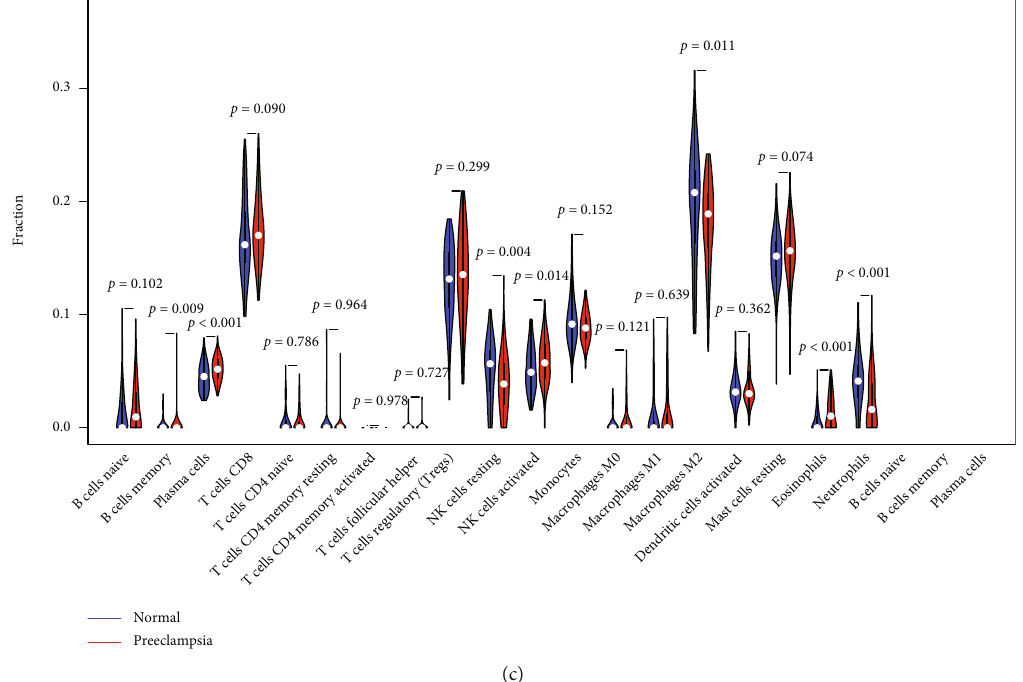
Figure 8: Immune cell pro fi le in preeclampsia samples and correlation analysis. (a) The amounts of immunocytes in every preeclampsia specimen are indicated with diverse colors. (b) Correlative matrix for the entire 22 immunocyte amounts. (c) Contrast of 22 immunocyte subtypes between preeclampsia samples and normal